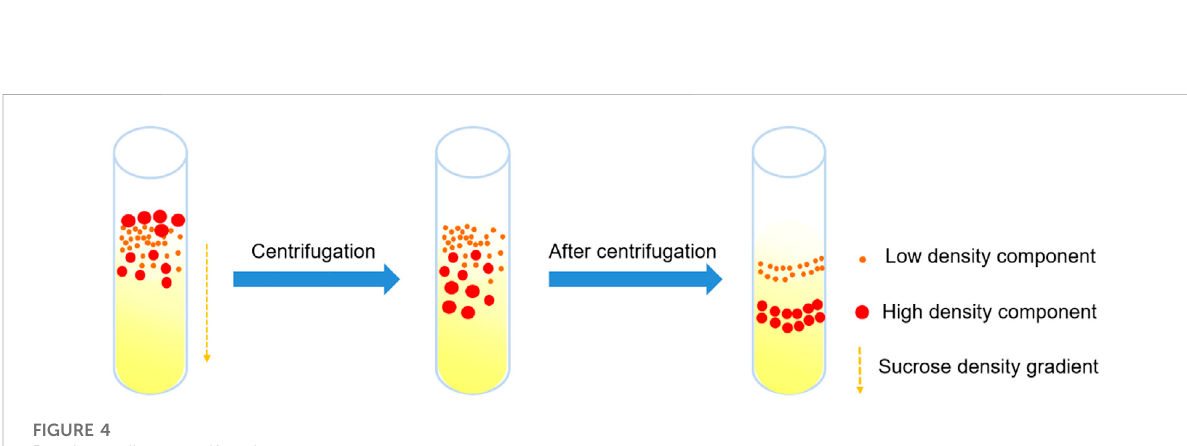
FIGURE 4 Density gradient centrifugation